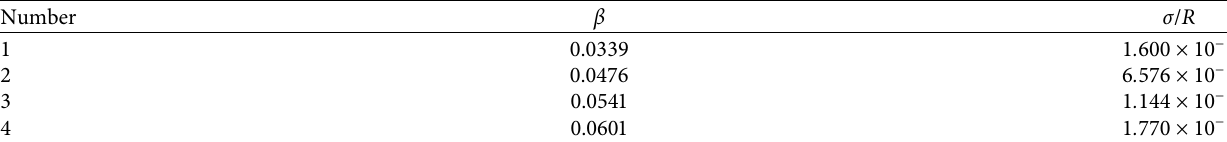
Table 1: Dimensionless surface roughness parameters [17].